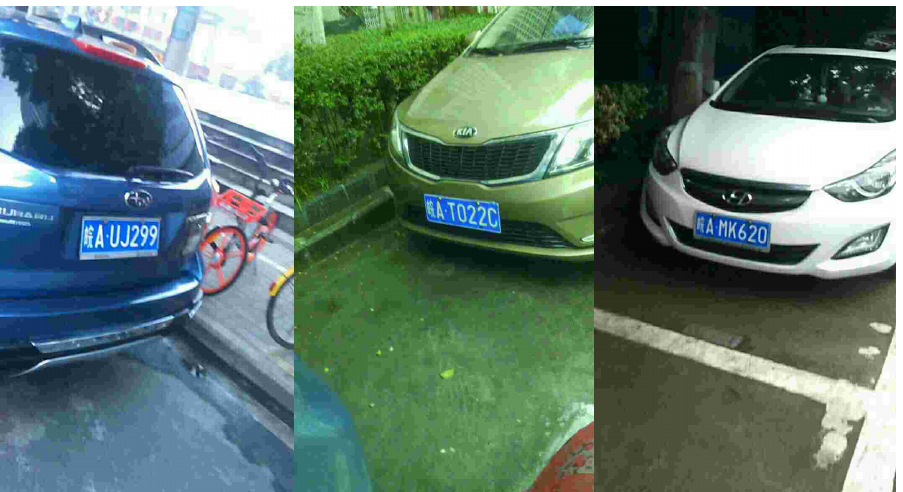
Figure 6. Sample images from the CCPD dataset. These license plates were collected in mainland China and are uniform nationally. Each is dark blue with white letters consisting of a province code character, city letter, and a unique ID number for the automobile consisting of letters and